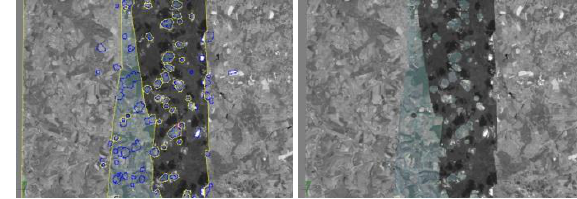
Figure 8. Cut lines around clouds and ortho mosaic without clouds (no colour balancing for better visualization) One of the unique algorithms we use to make ortho mosaics look better is the usage of tie points that are calculated along cut lines using standard cross-correlation algorithm. The images can be stitched by a limited predefined value using these tie points to eliminate discrepancies along seams (cut lines) as illustrated on the following picture.